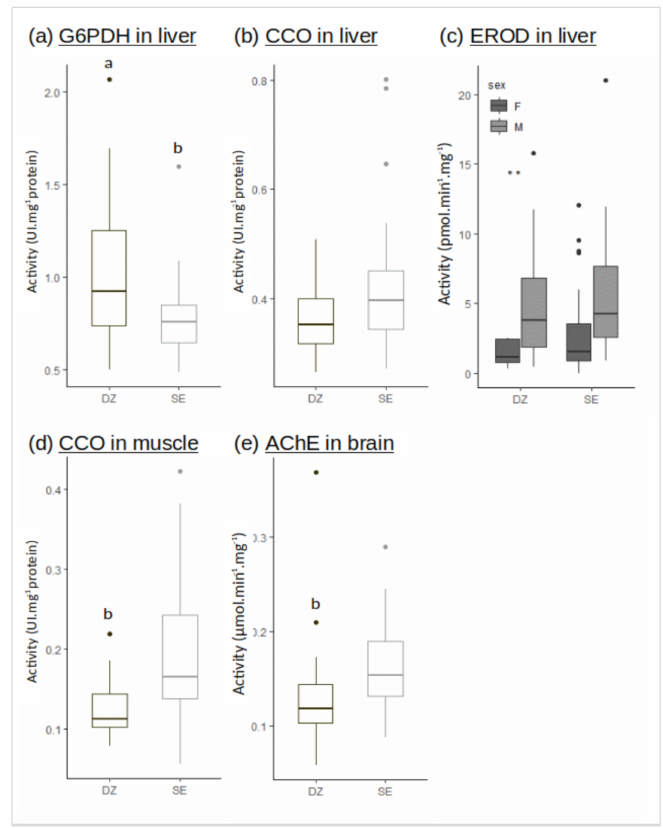
Figure 3. Enzymatic activities in liver (( a ) G6PDH, ( b ) CCO, ( c ) EROD), muscle (( d ) CCO), brain (( e ) AChE) in the Douarnenez bay (DZ) and in the Seine estuary (SE). Letters indicate significant di ff erence between mean flounder population of DZ and SE (Kruskal-Wallis test: p -value < 0.001). Two stars ** indicate a significant di ff erence within the Douarnenez population (Kruskal-Wallis test: p -value <